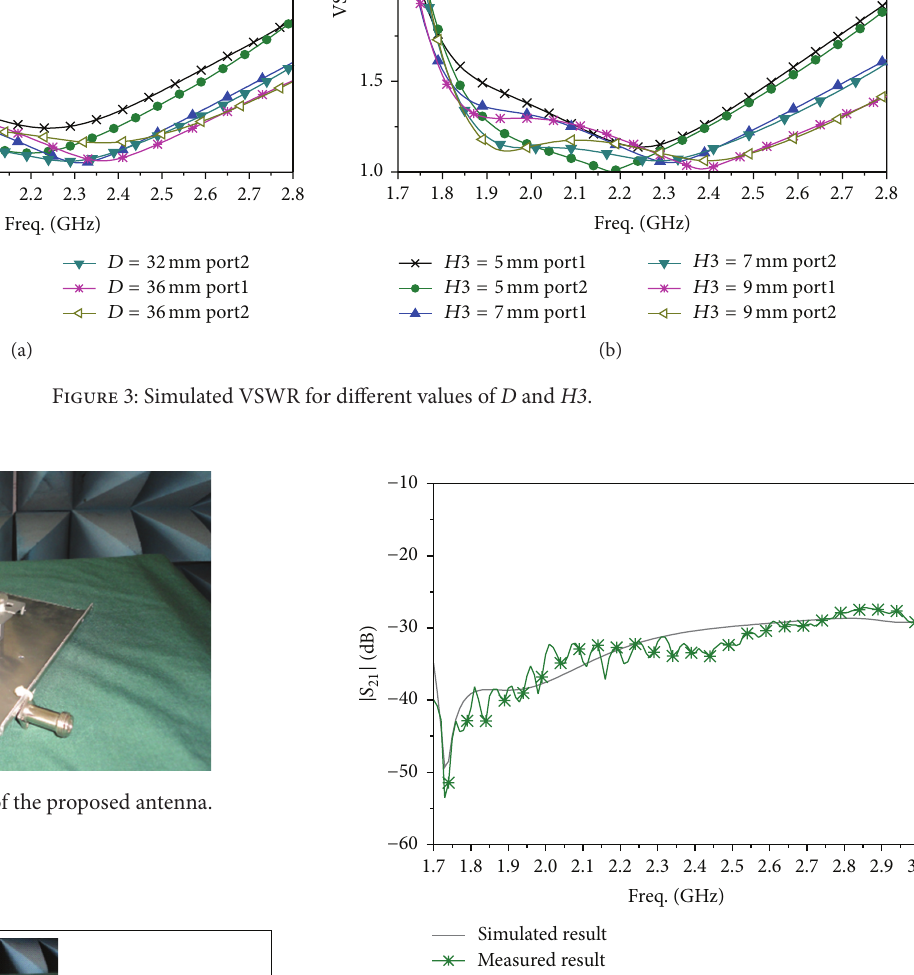
Figure 6: Simulated and measured | S21 | of the proposed